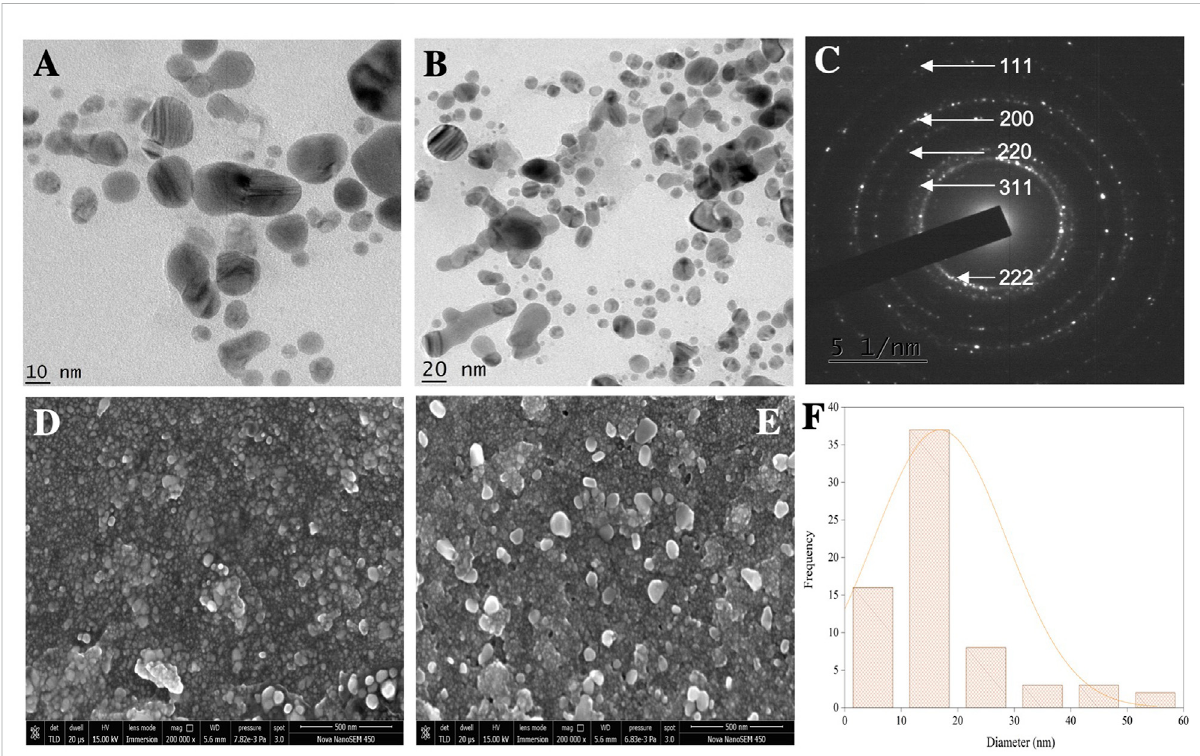
FIGURE 5 (A,B) TEM micrographs of AgNPs. (C) SAED pattern. (D,E) SEM micrographs. (F) Histogram showing the average particle size distribution of synthesized